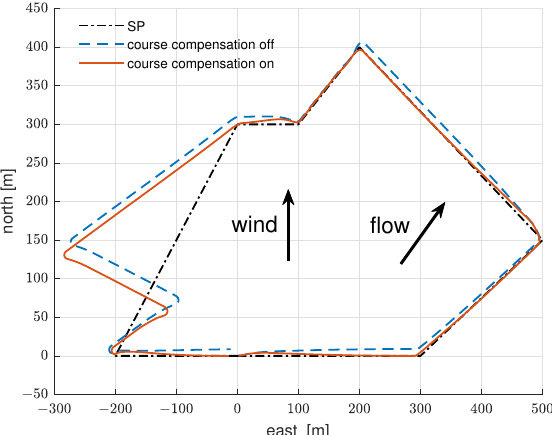
Figure 16. The sailing trajectory of LOS with and without heading compensation when there is current interference. The trajectory of waypoints in Table 3 with wind direction at 0 degree, wind speed at 5 m/s. The black dotted line SP is the reference trajectory, the blue dashed line is the case without heading compensation, and the orange solid line is the case with heading compensation.